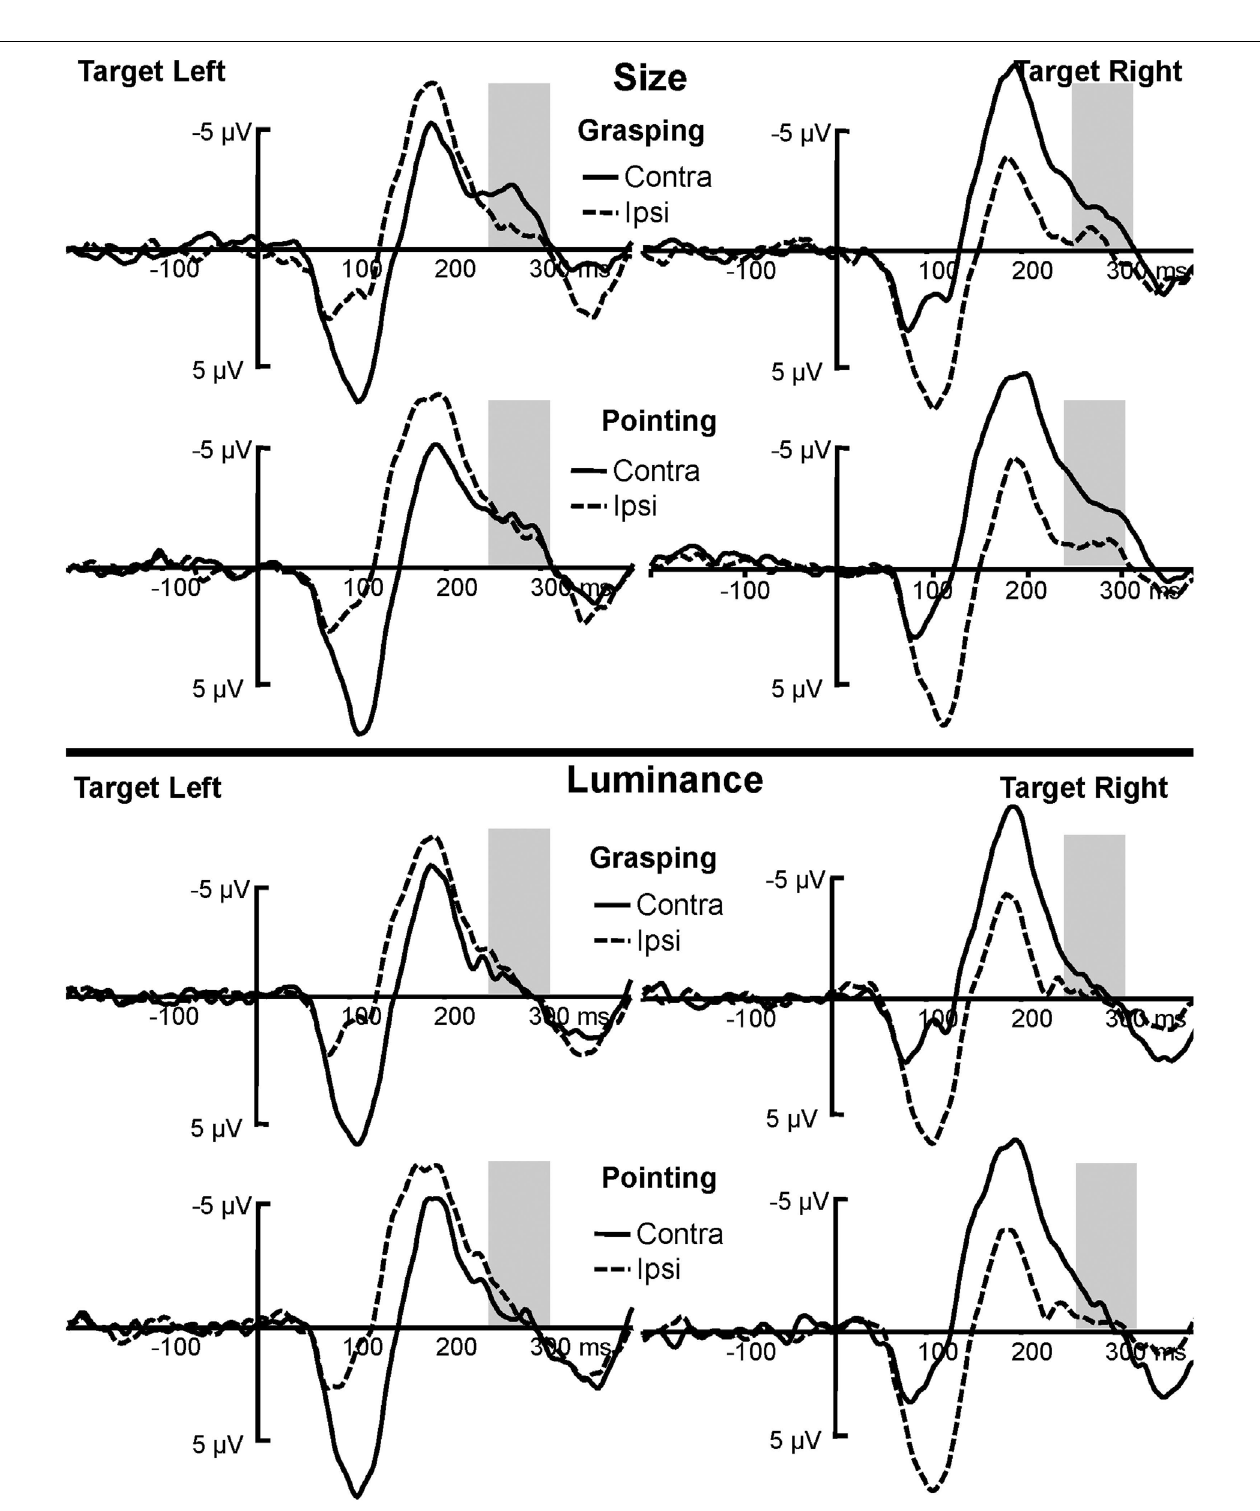
lines in the graphs on the right side).Therefore the visible difference between contra- and ipsilateral waveforms on the P1 and N1 components is due to more positive amplitude on the PO8 electrode, independent of condition.This might be related to attentional networks being located in the right cerebral hemisphere (e.g., Heilman andVan Den Abell, 1980; Mesulam, 1981; Sperry, 1974;Thiebaut et al.,